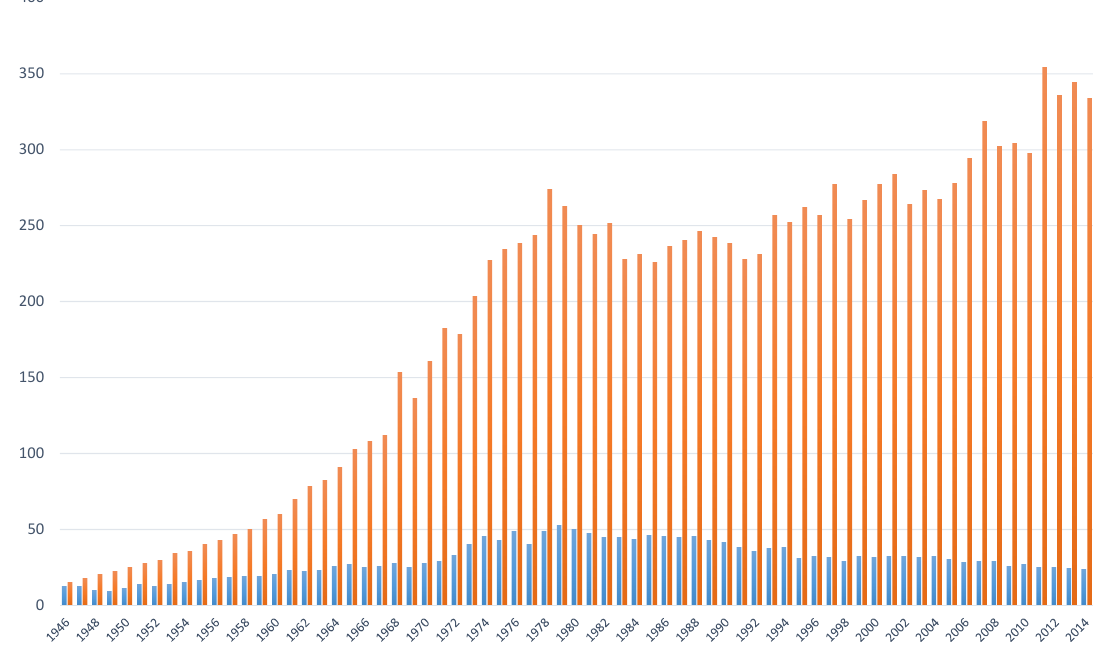
Figure 3. Scotch whisky consumption (mlpa). Sourced from SWA statistics and The making of Scotch